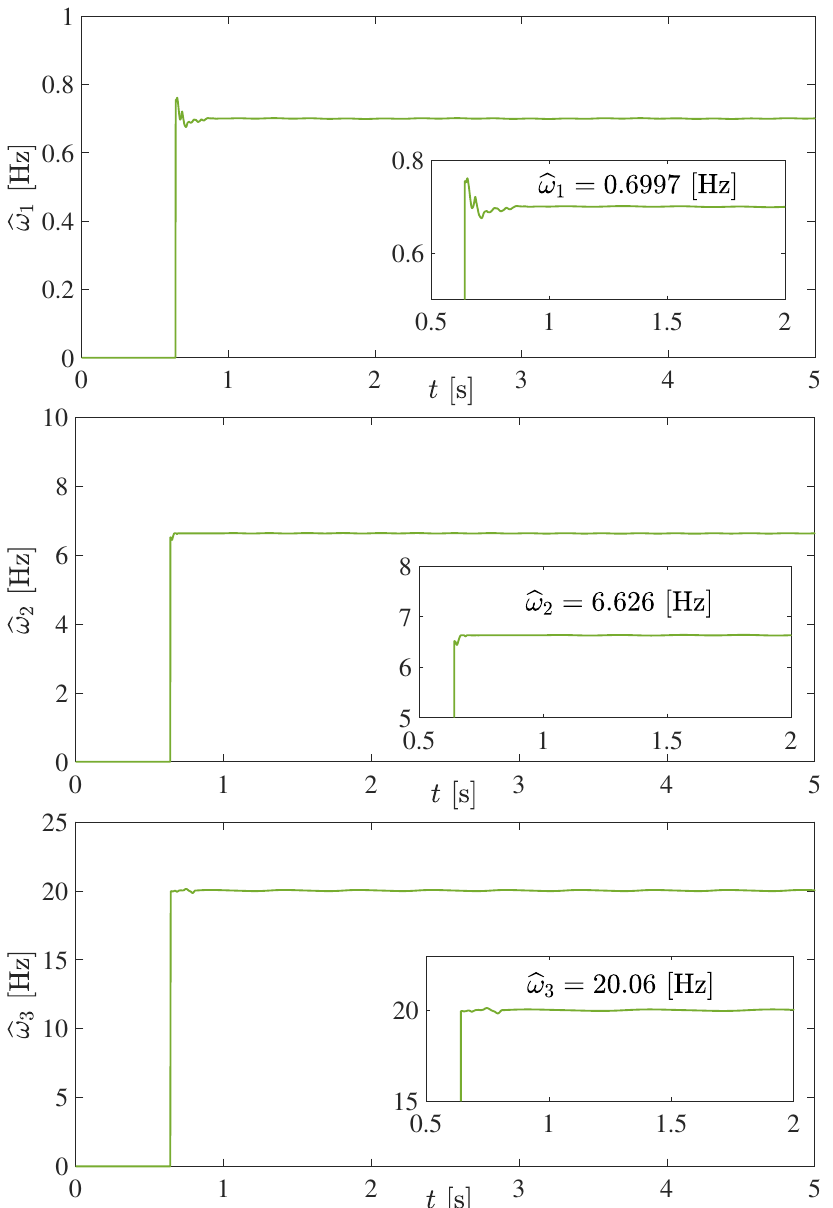
Figure 6. Online algebraic estimation of the first three natural frequencies of the distributed- parameter